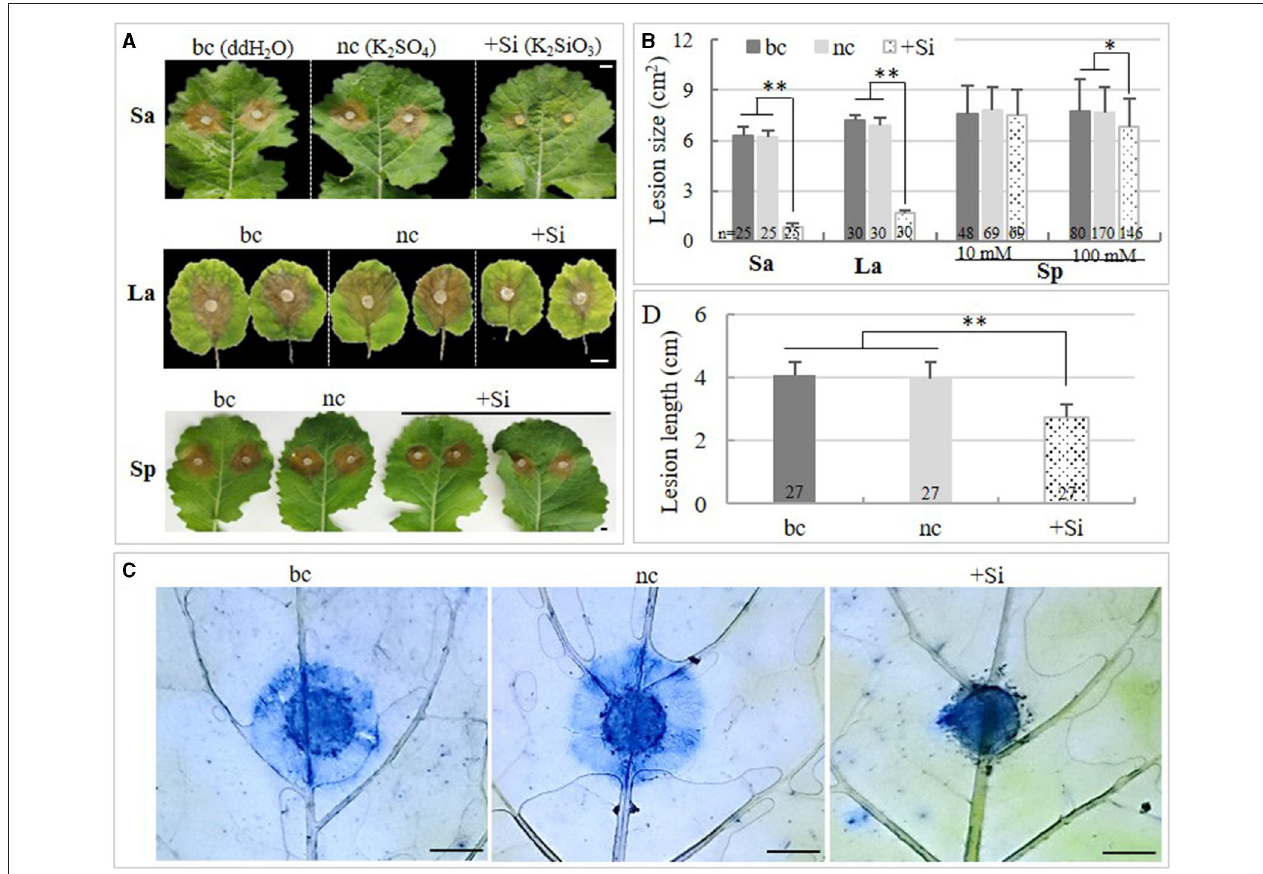
FIGURE 1 | Effects of K 2 SiO 3 on plant resistance to Sclerotinia sclerotiorum in absorption and spray assays. (A) Disease symptoms of inoculated rapeseed leaves under the K 2 SiO 3 treatment ( + Si), K 2 SO 4 treatment (the negative control, nc), and ddH 2 O treatment (the black control, bc). Sa: short-time absorption assay; La: long-term absorption assay; Sp: spray assay. Bars = 1cm. (B) Comparison of lesion size on the inoculated leaves of rapeseed plants among treatments. (C) Comparison on the proliferation of S. sclerotiorum on rapeseed leaves at 24 hai among treatments. The trypan blue staining was applied, and mycelia and necrosis were stained in blue. Bars = 5mm. (D) Comparison of lesion length on the stems of the rapeseeds among treatments in the spray assay. The number on the bottom of each bar in (B) and (D) represents the number of samples tested. * and ** indicate significant differences at the p < 0.05 and p < 0.001 levels, respectively.